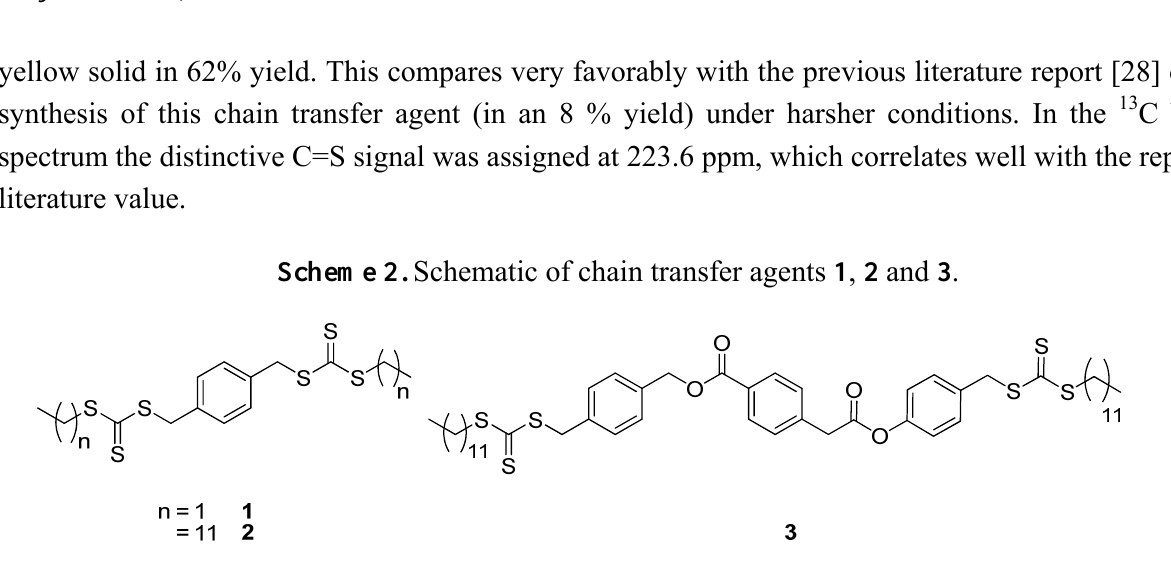
Figure 1. 1 H NMR spectrum of a) 3a and b) 3 both in CDCl